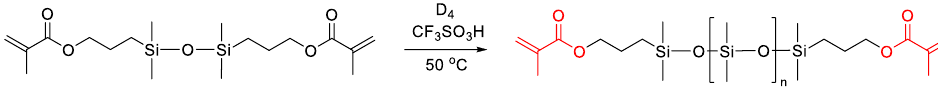
Figure 26. Synthesis of α, ω -bis(methacryl) PDMS.